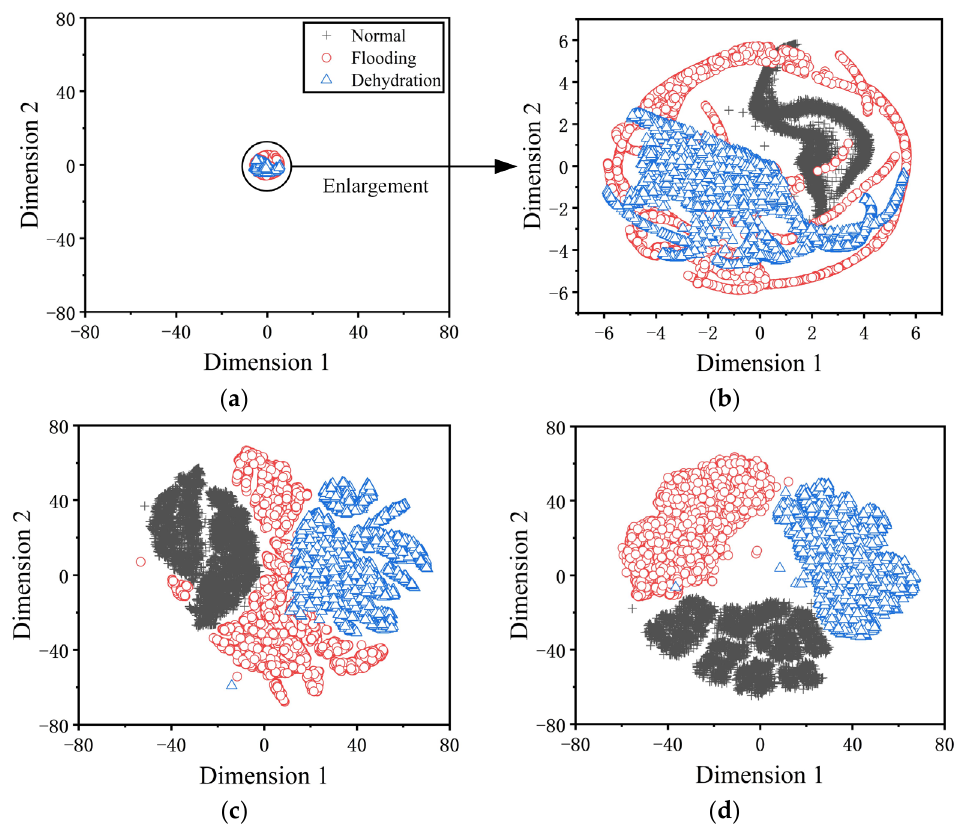
Figure 8. Feature visualization with the t-distributed Stochastic Neighbor Embedding (t-SNE) technique (red point-flooding, black point-dehydration, green point-normal). ( a ) Raw data; ( b ) Enlargement of raw data; ( c ) 1D-CNN; ( d ) The proposed method